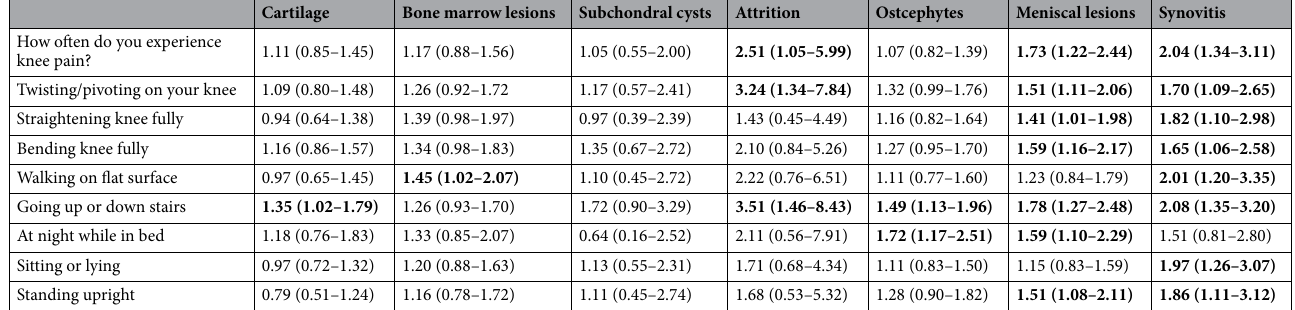
Table 6. The association between MRI lesions and knee pains with certain activities. Logistic regression analysis was performed on knees with Kellgren–Lawrence grade 0 or 1 in radiographs. Dependent variables was the presence of each knee pains; the independent variables were age, BMI, and each MRI lesion. Bold denotes statistical significance at P <